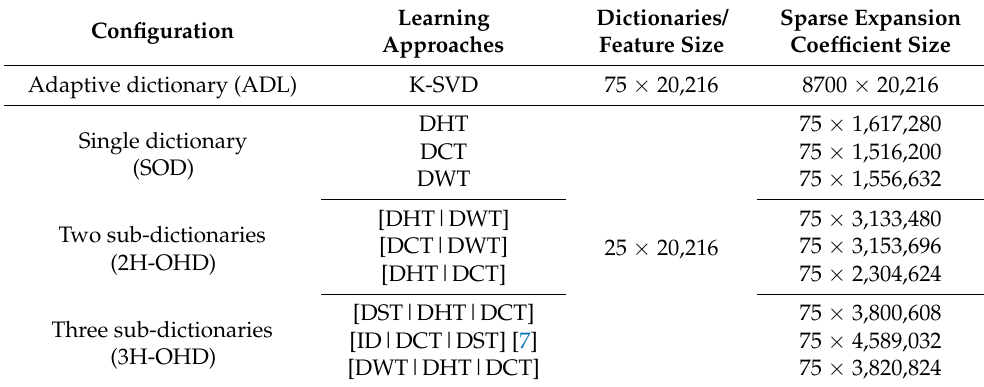
Table 3. Parameters used to train single, hybrids and adaptive supervised dictionary